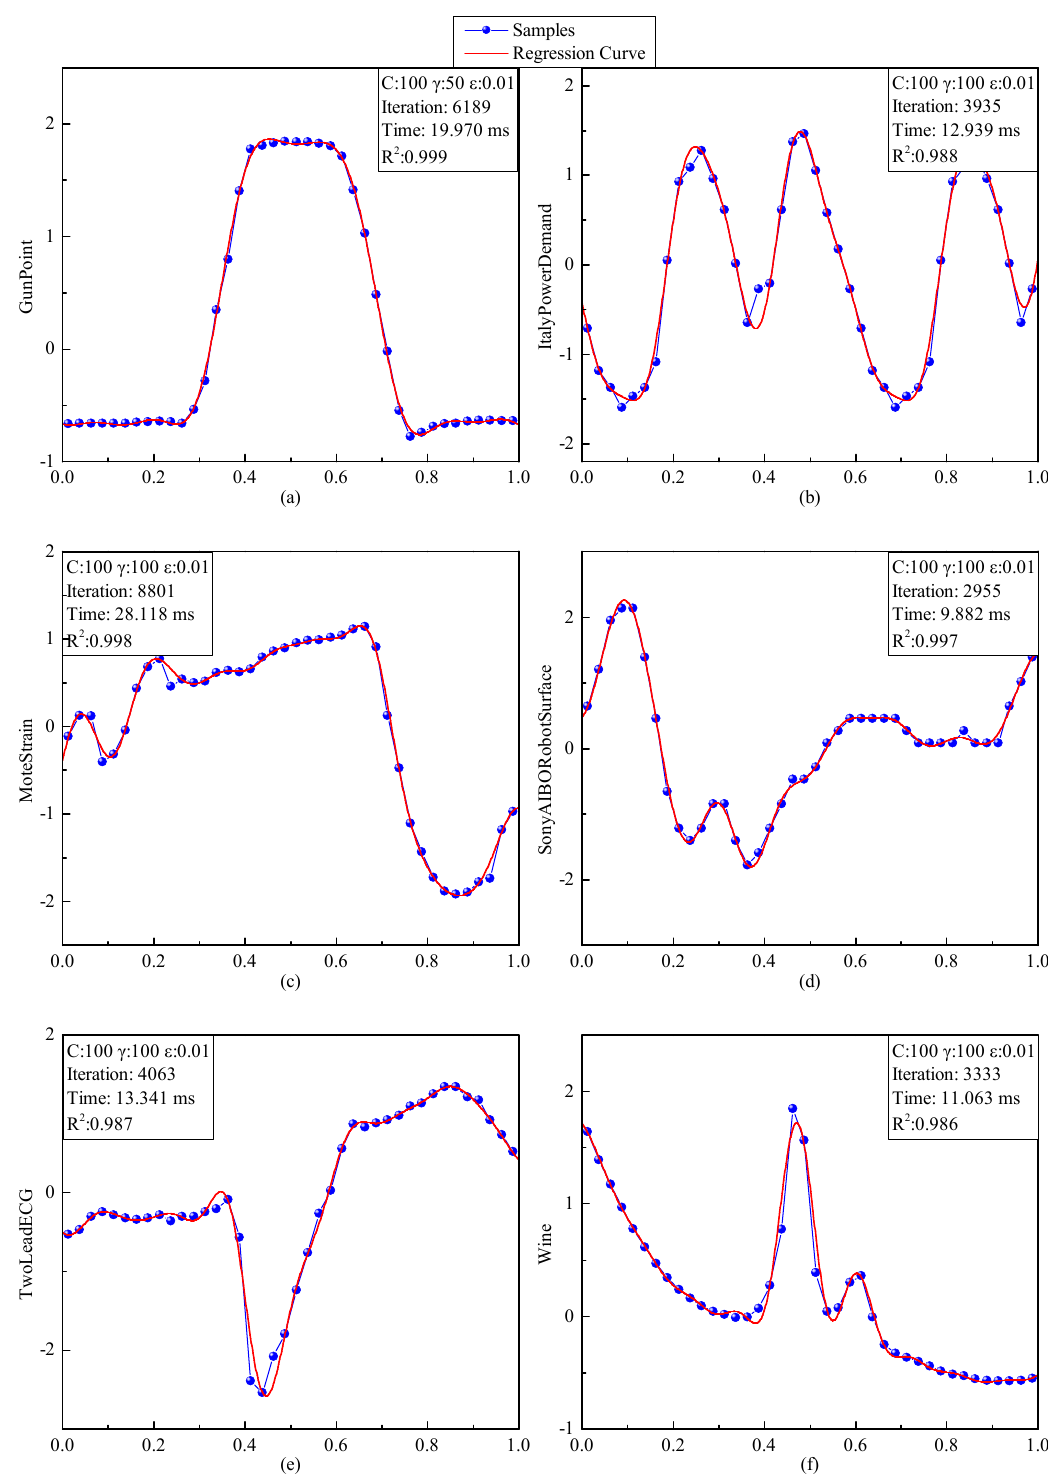
Figure 14. Regression results of the University of California, Riverside (UCR) time series dataset.